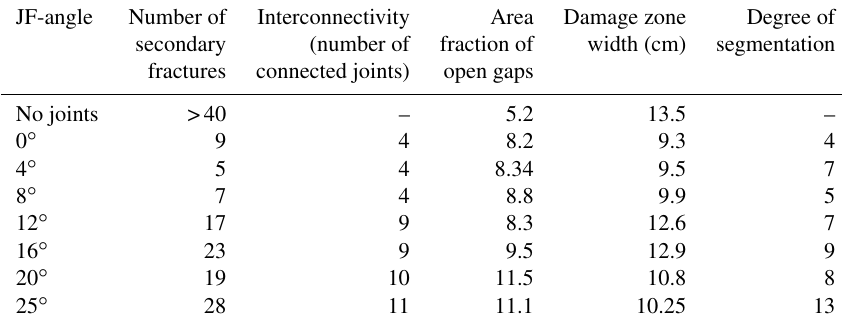
Table 2. Summary of the measured data. Plot in Fig. 11. JF-angle Number of Interconnectivity Area Damage zone Degree of secondary (number of fraction of width (cm) segmentation fractures connected joints) open gaps No joints >40 – 0 ◦ 9